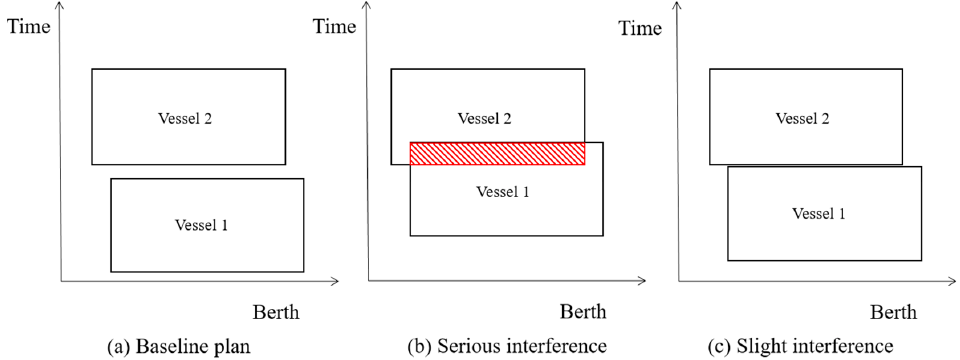
Figure 4. Interference degree diagram. ( a ) Baseline plan; ( b ) Serious interference; ( c ) Slight interference.